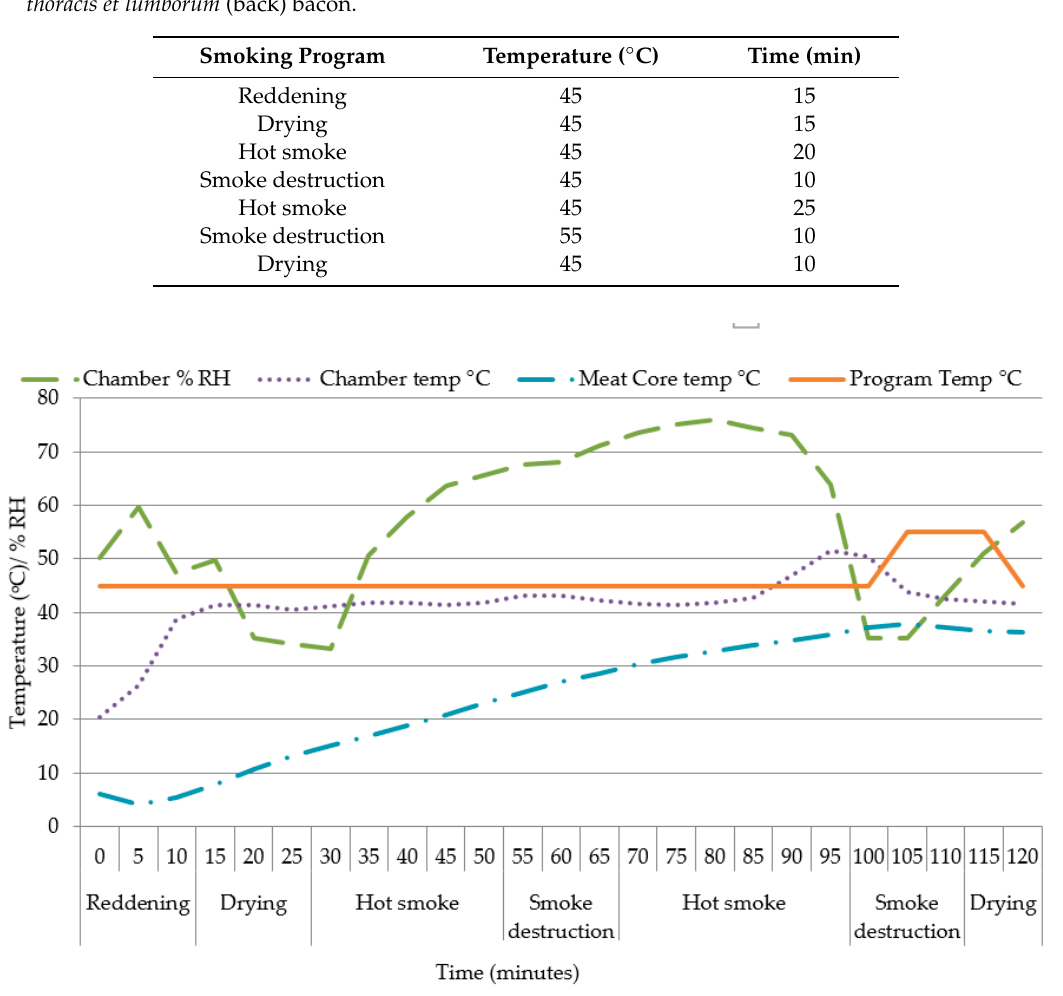
Figure 1. The temperature (°C) and relative humidity (% RH) of the smoking program and temperature (°C) of the chamber and core of Longissimus thoracis et lumborum (back)